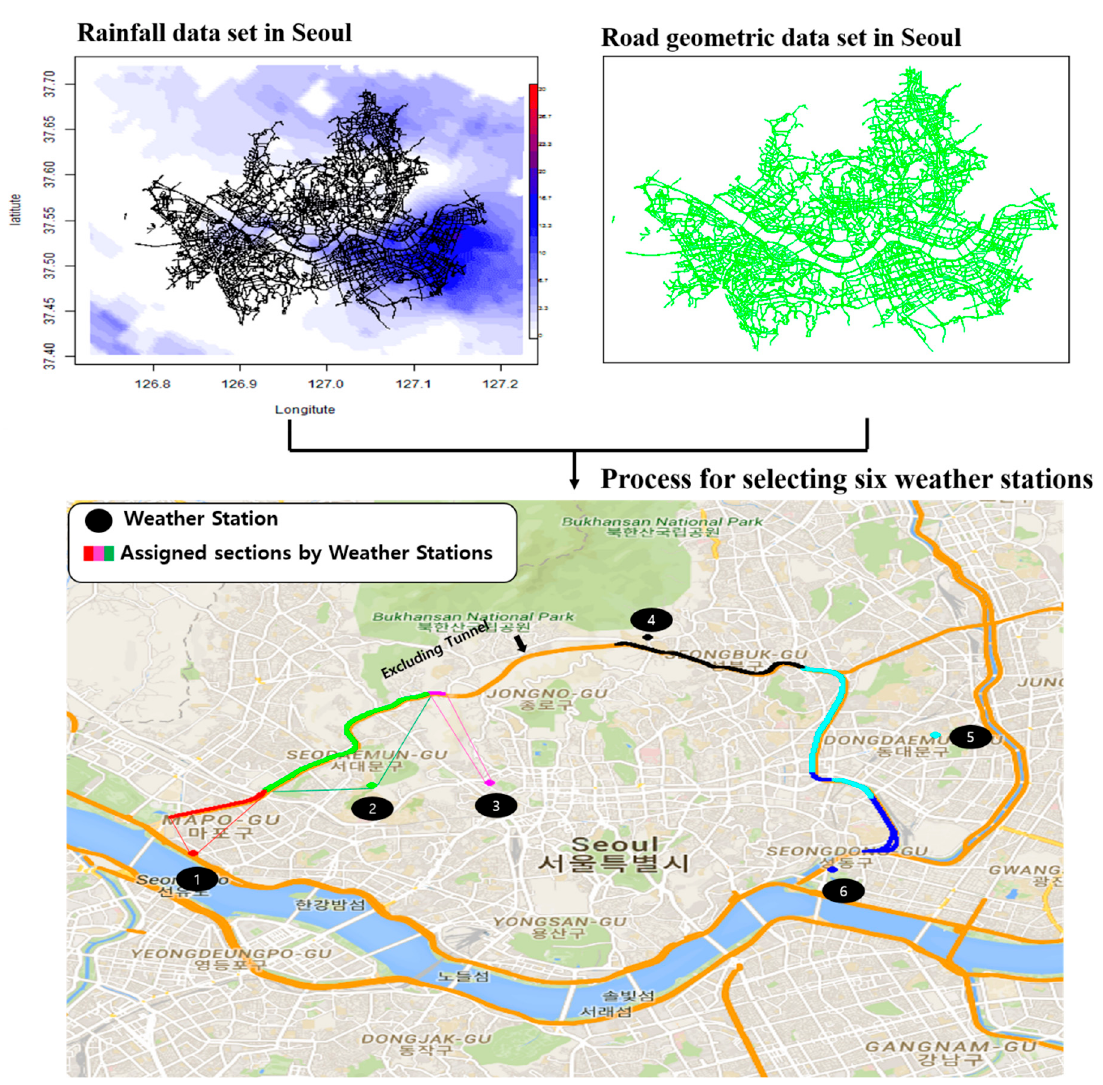
Figure 5. Process for estimating rainfall on the Naebu Expressway.